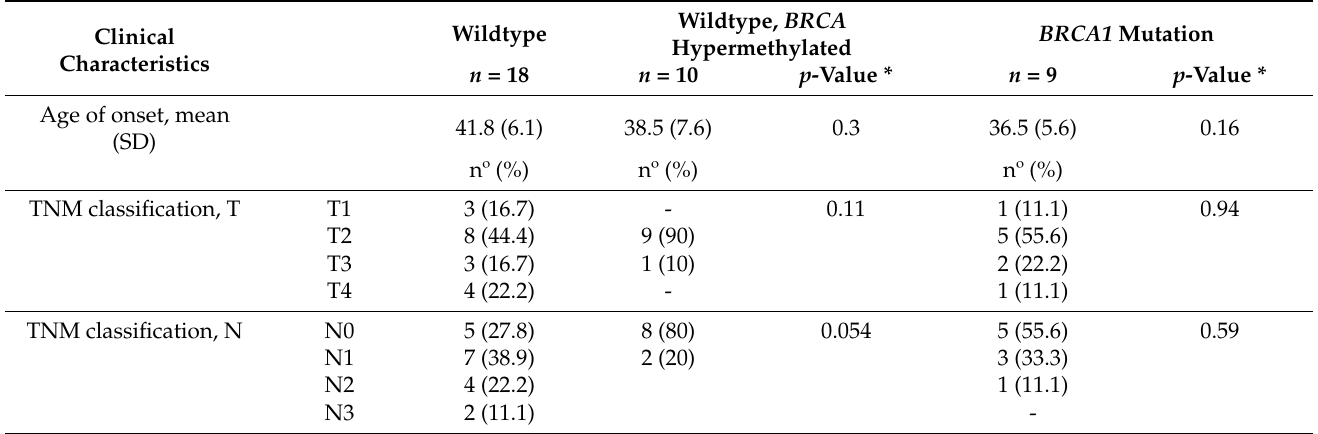
Table 1. Clinical characteristics and outcome of TNBC